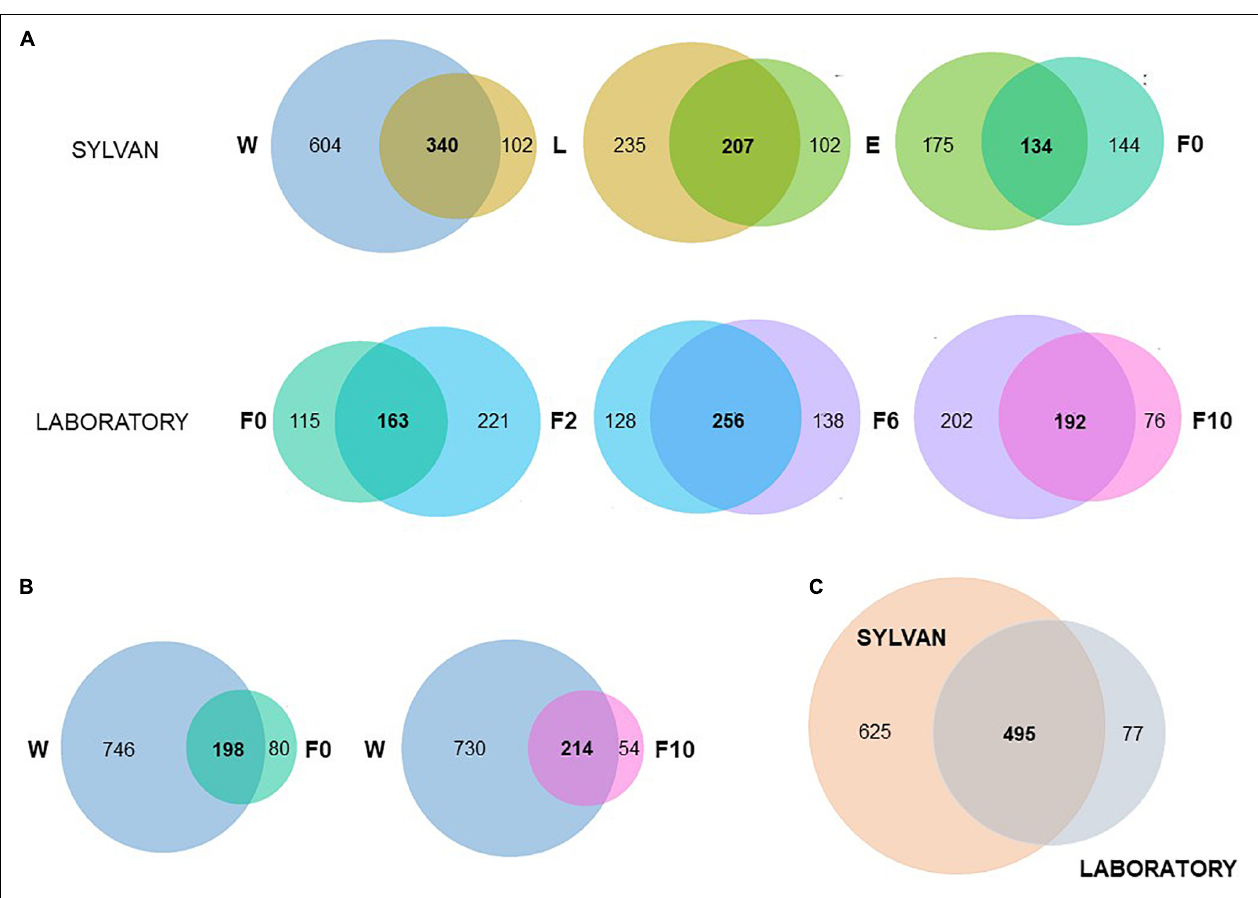
FIGURE 4 | Microbiota of An. atroparvus persists across sylvan samples and laboratory time points. Venn diagrams showing the number of shared genera (present in at least one pool, out of three, of both groups) among subsequent pairs (A) , between natural breeding water with wild-caught females and with laboratory-reared females from the 10th generation (B) , and between sylvan and laboratory environments (C) . Sample types: W, breeding water; L, larvae; E, newly emerged females; F0, wild-caught females; F2, F6, and F10, laboratory-reared females from the second, sixth, and 10th generations,